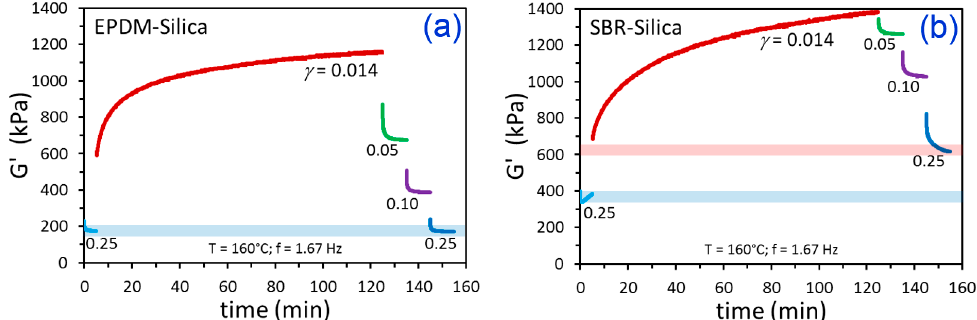
Figure 3. Time-dependent G’ results from the indicated strain amplitude history for EPDM-Silica ( a ) and SBR-Silica ( b ). The blue bar in ( a ) represents the similar starting and ending values of G’ at γ = 0.25. In ( b ), the blue bar is the starting G’ at γ = 0.25 and the pink bar is the final G’ at γ = 0.25, which is higher.